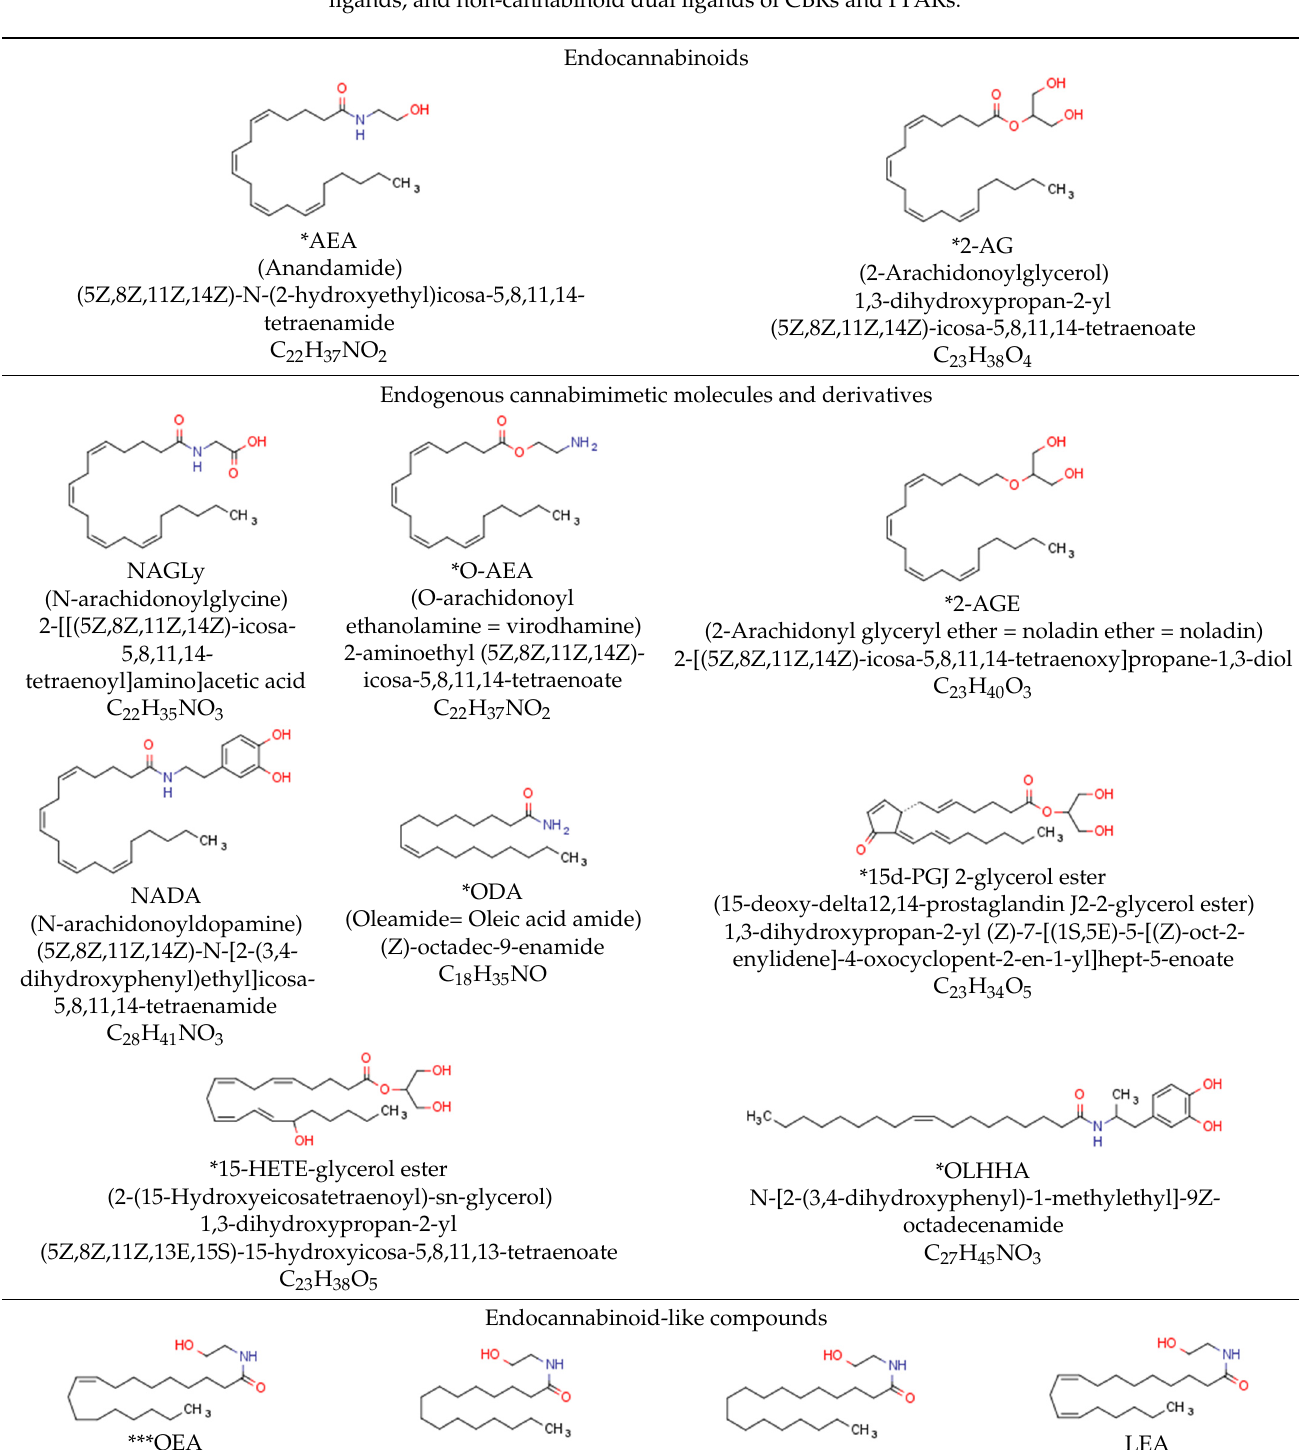
Cells 2022 , 11 , x FOR PEER REVIEW 6 of 38 3.1.1. Endocannabinoids Endocannabinoids include two primary compounds, anandamide (AEA) [64] and 2-arachidonoylglycerol (2-AG) [65], together with other endogenous cannabimimetic molecules and endocannabinoid-like compounds. Other endogenous cannabimimetic molecules include oleamide (ODA), virodhamine (O-AEA), noladin ether (2-AGE), N- arachidonoyldopamine (NADA), and N-arachidonoylglycine (NAGly) [66]. The main endocannabinoid-like compounds include oleoylethanolamide (OEA), palmitoylethano- lamide (PEA), stearoylethanolamide (SEA), and linoleoylethanolamide (LEA) [67]. The primary receptors for both major endocannabinoids are cannabinoid receptor type 1 (CB1R) and CB2R (Table 2). Table 2. Cannabinoids, canabimimetic molecules, cannabinoid-like molecules and derivatives, PPAR ligands, and non-cannabinoid dual ligands of CBRs and PPARs.